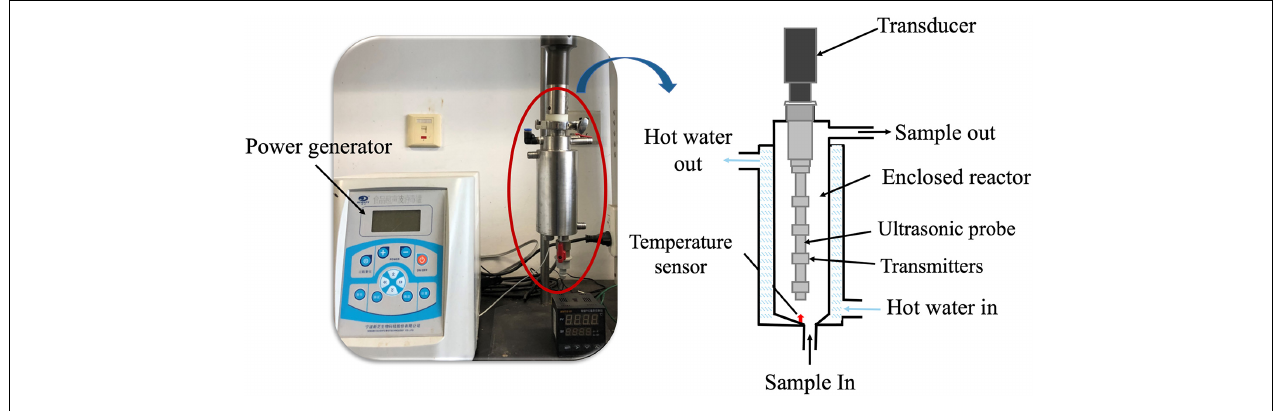
FIGURE 1 | Diagram of the 360-degree radiation thermosonication